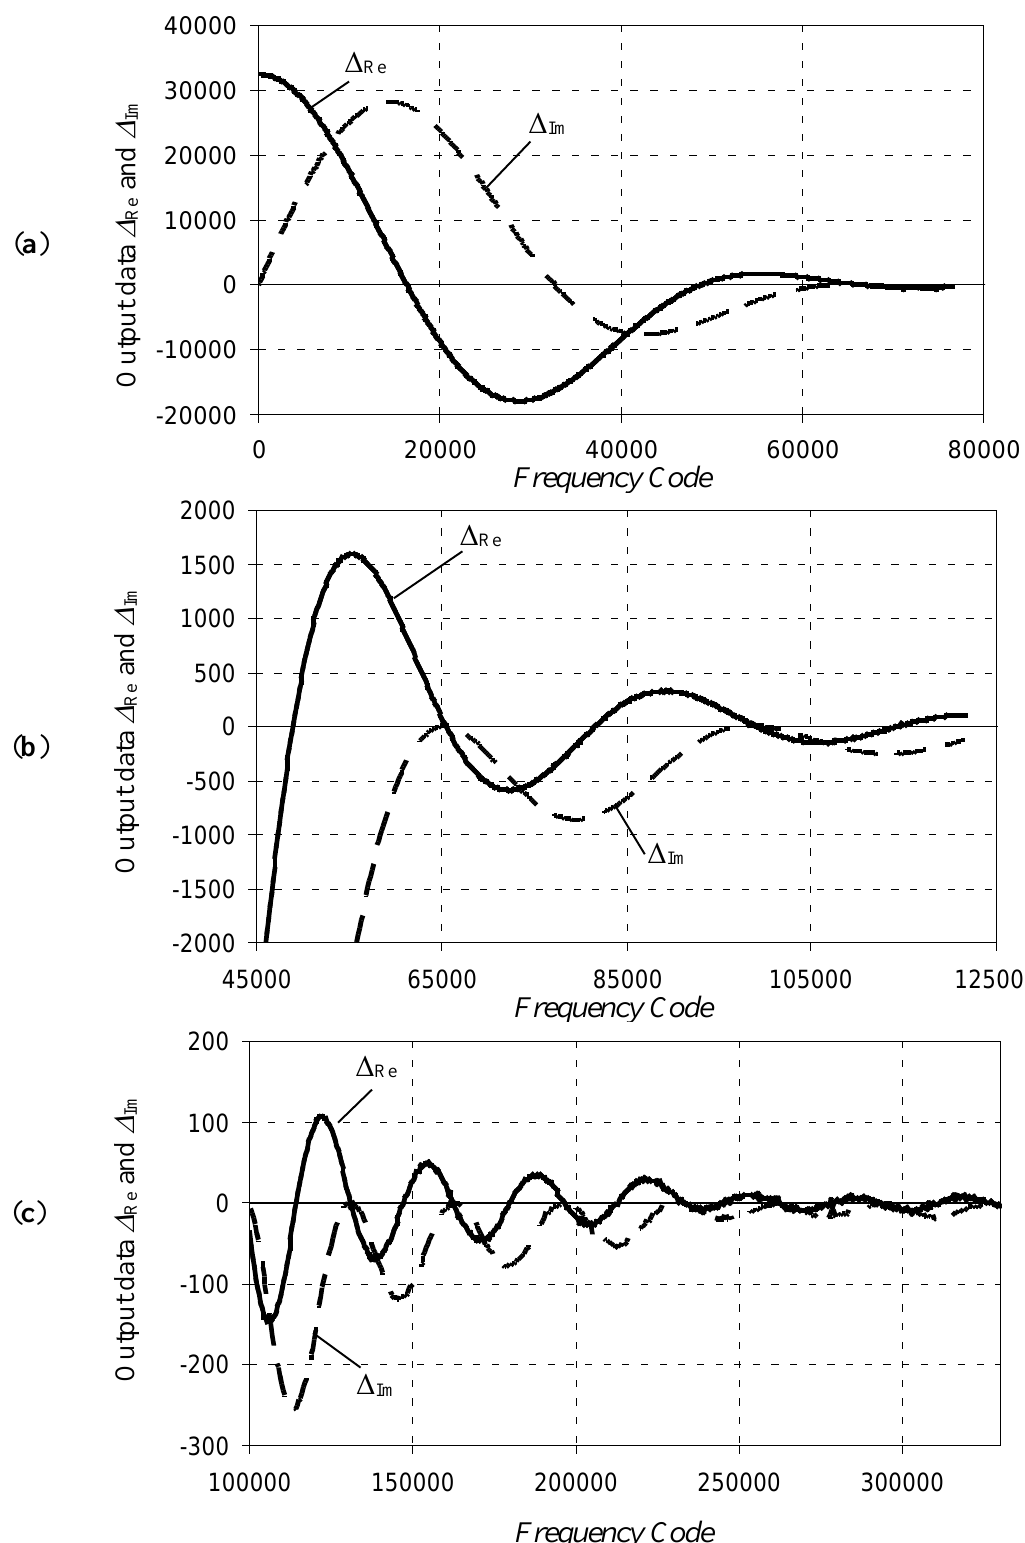
Figure 6. Experimentally observed internal DC leakage Δ Re and Δ Im : data from the AD5933 “Real” and “Imaginary” output registers respectively, collected over 3 frequency ranges ( a – c